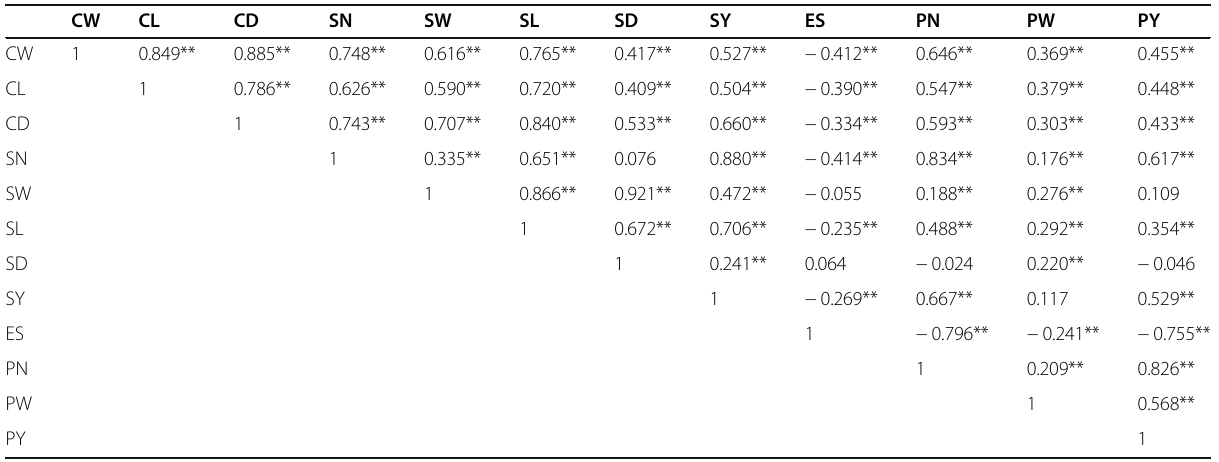
* and ** stating significant differences at 0.05 and 0.01 levels, respectively. For abbreviations, please see Table